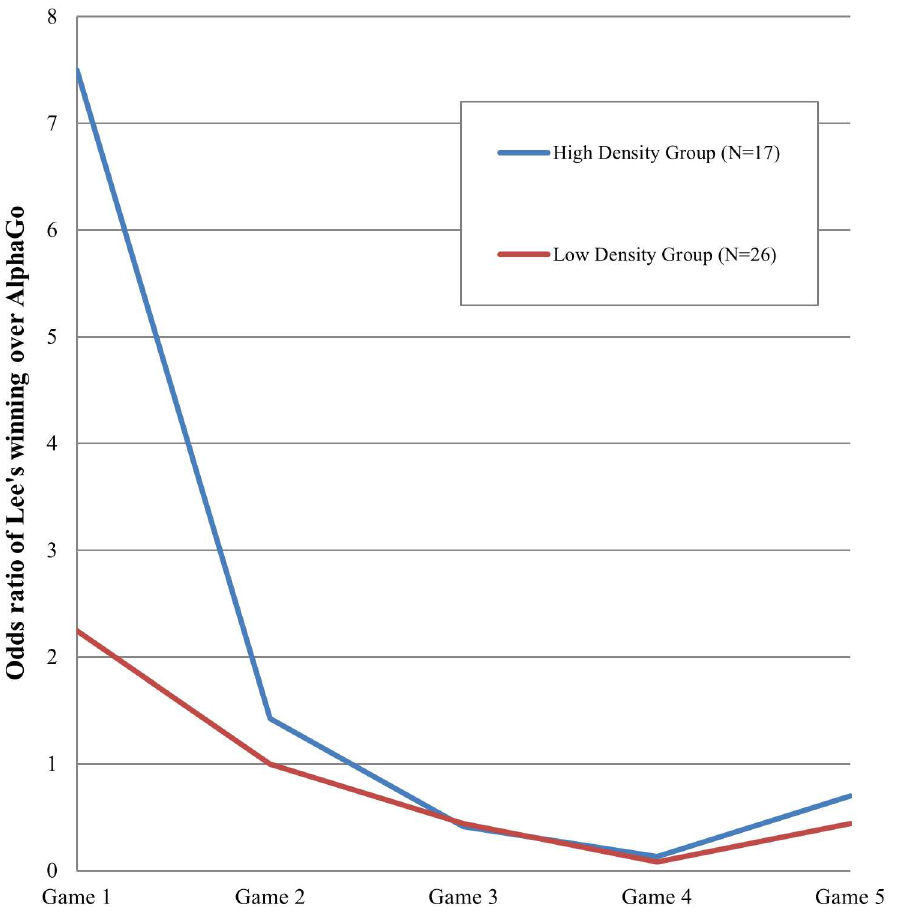
Fig 5. Network density and the prediction of Lee’s winning. Y axis refers to the odds ratio of the proportionof those who predictedLee’s winning. N =